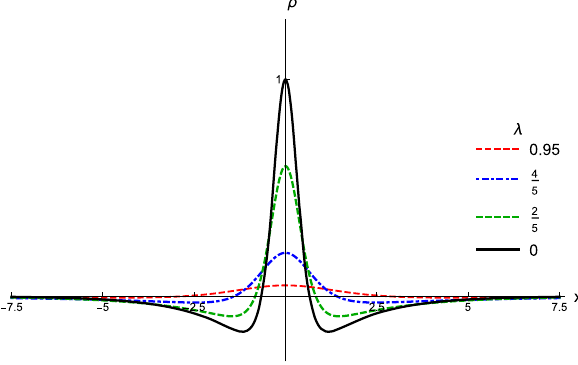
infinite extent to a 5-dimensional Minkowski spacetime with no graviton